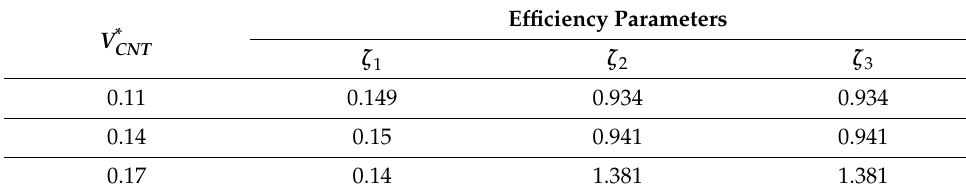
Table 1. Efficiency coefficients for different CNT volume fractions.